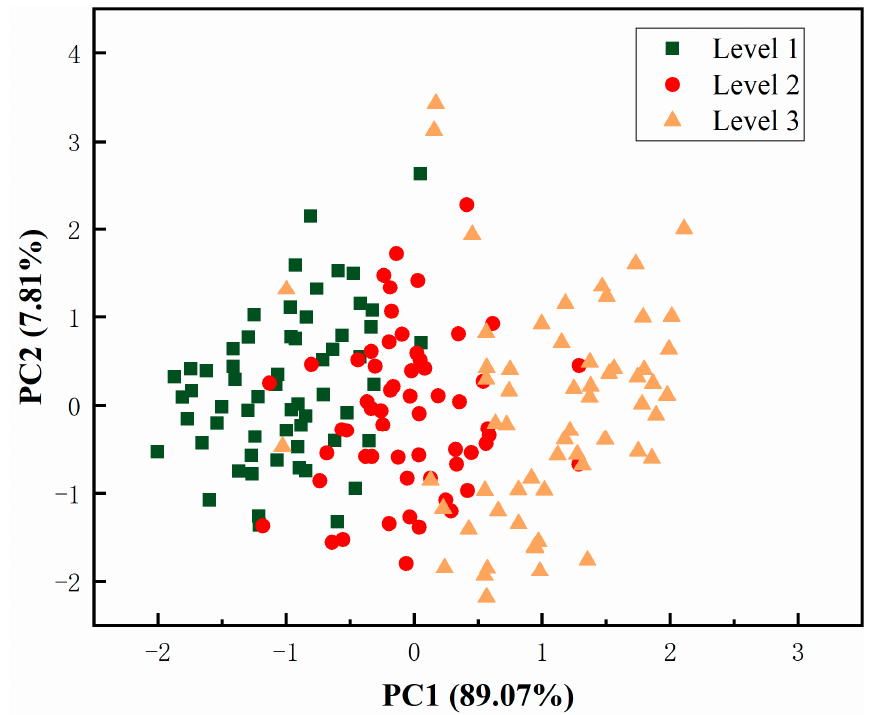
Figure 4. Loading plot of PC1 and PC2 derived from raw spectra for mini-Chinese cabbage at different freshness levels.